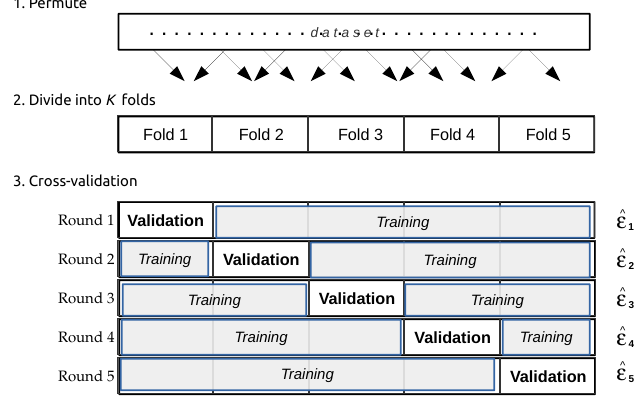
Figure 9. Illustration of a 5 -fold cross validation process. The general dataset is permuted and split into five folds. Afterwards, cross-validation is run through five rounds. In each round, one of the folds is kept for testing while the others are used for